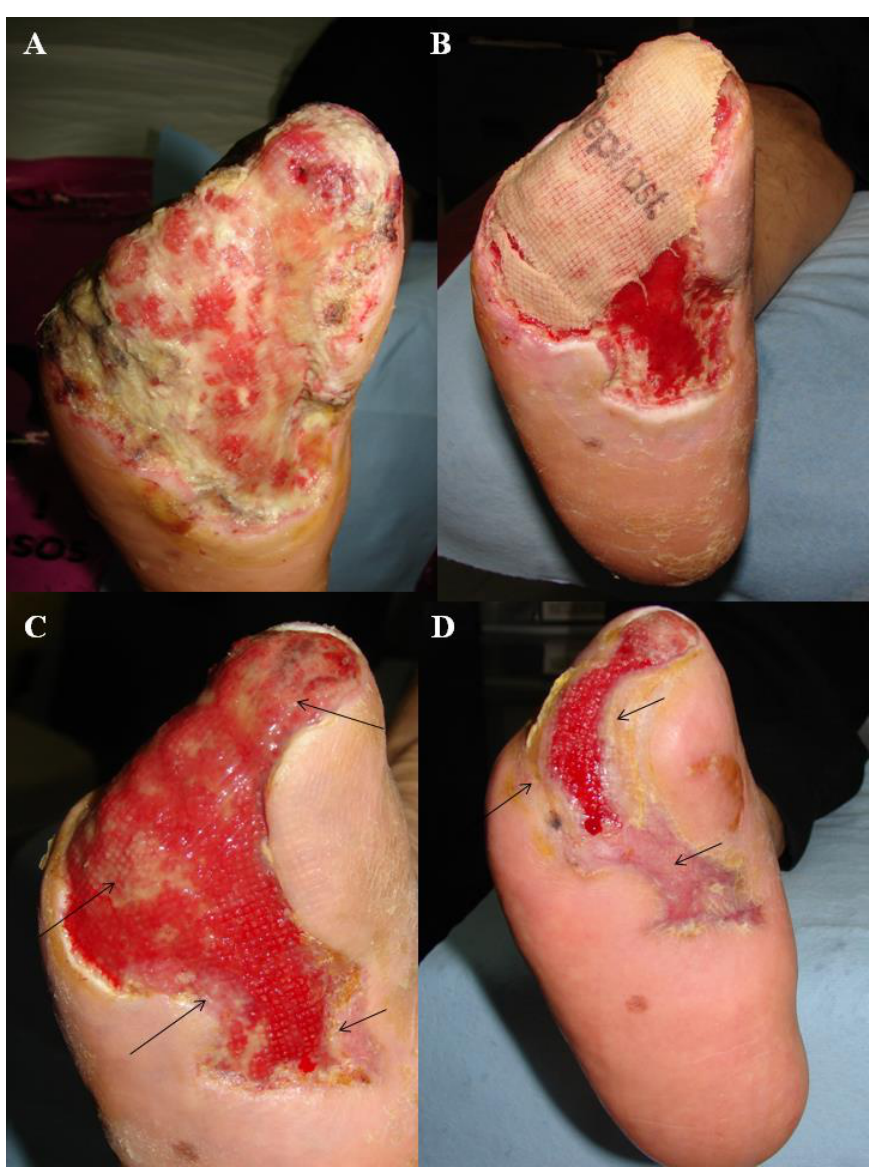
Figure 3. ( A ) 100 cm 2 complex, difficult to heal diabetic foot wound in the granulation phase after random assignment to the Epifast group. ( B ) A granulating wound covered by Epifast after 3 weeks, enhanced by growth factors present in the Epifast. ( C ) Arrows indicate newly formed skin 8 weeks after treatment. ( D ) Spread of epithelialization after 16 weeks. Total epithelialization was achieved 2 weeks